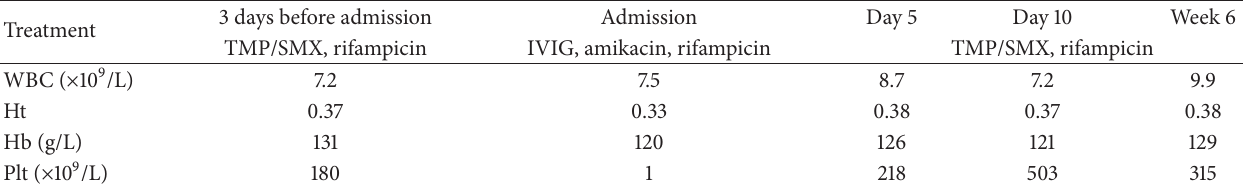
Table 1: Hematological parameters and treatment at admission and during the course of the disease.